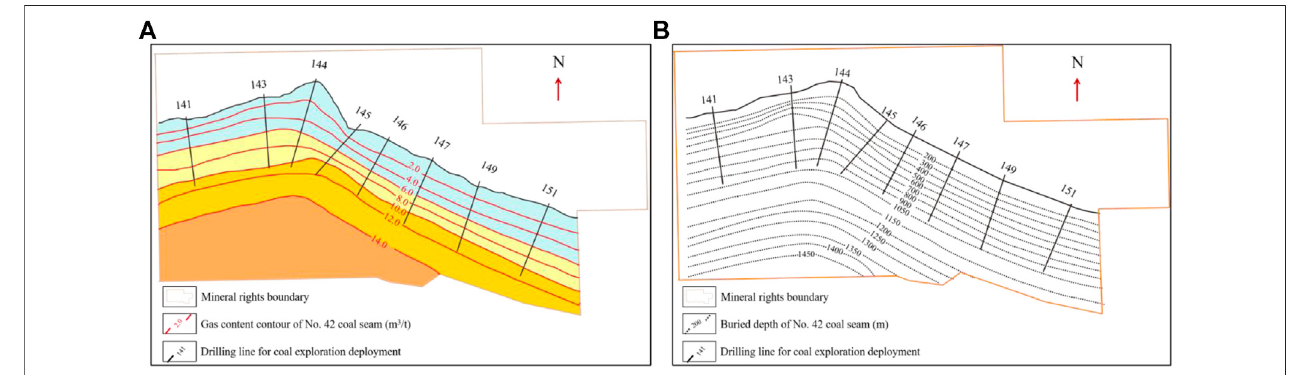
FIGURE 4 | (A) Gas content contour and (B) buried depth contour of No. 42 coal seam in the Baiyanghe mining area.